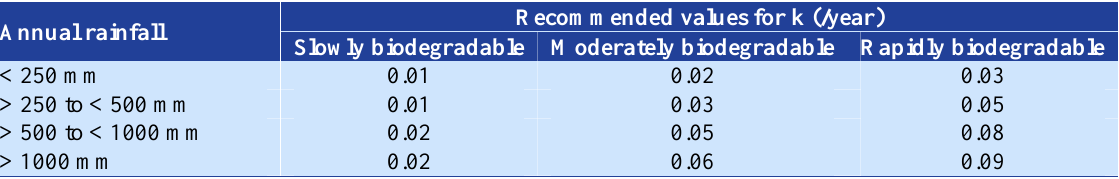
Table 1. Different k values (/year) of waste components for different precipitation conditions based on the World Bank recommendation 14